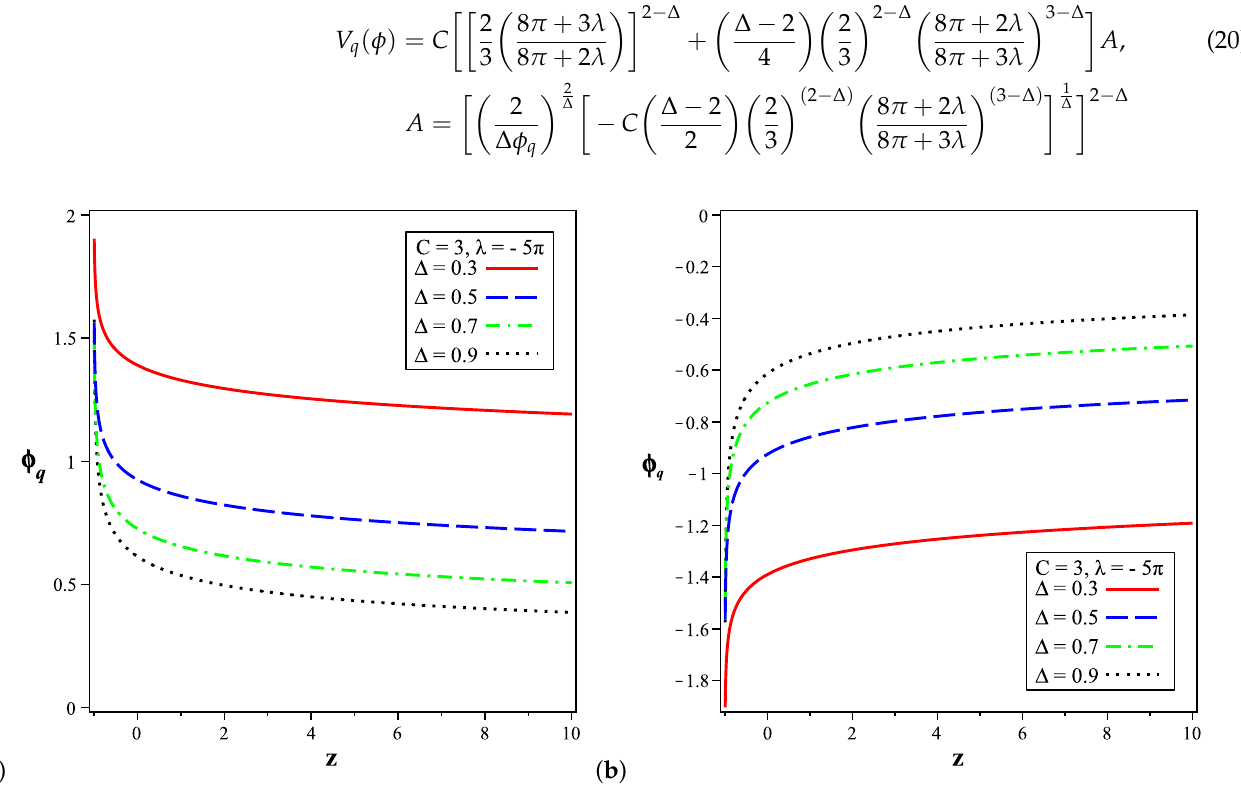
Figure 1. Depicting the nature between the redshift( z ) and the Barrow holographic quintessence scalar field ( φ q ) , ( a ) ( φ q ) is positive and ( b ) ( φ q ) is negative; here, C = 3 and λ = − 5 π